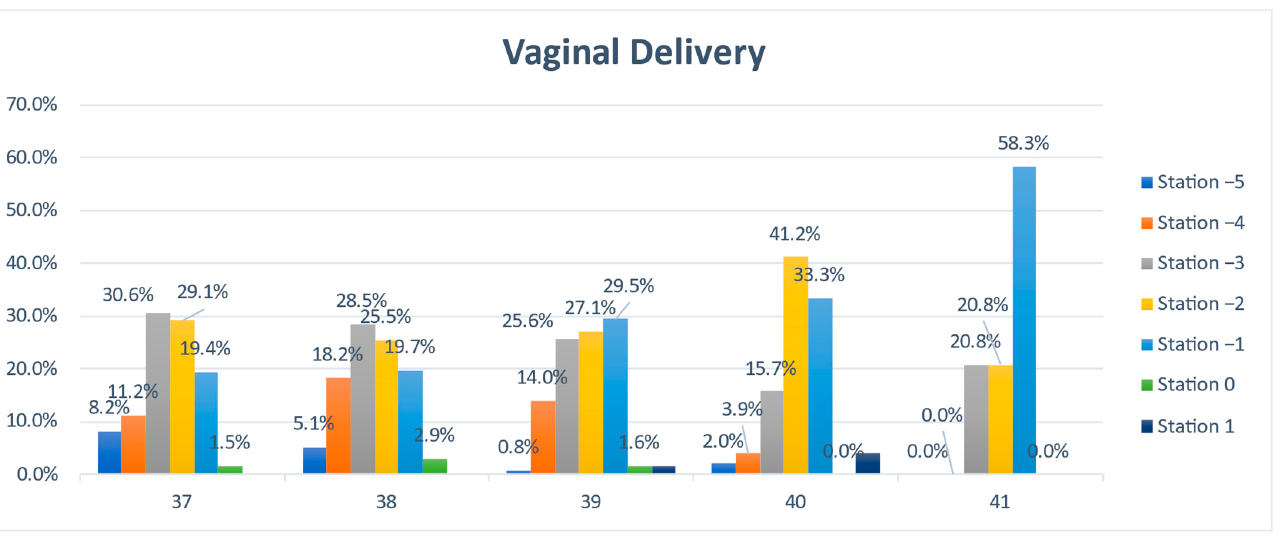
Figure 2. Box plot showing the distribution of the fetal head station at 37 to 41 weeks of gestation.